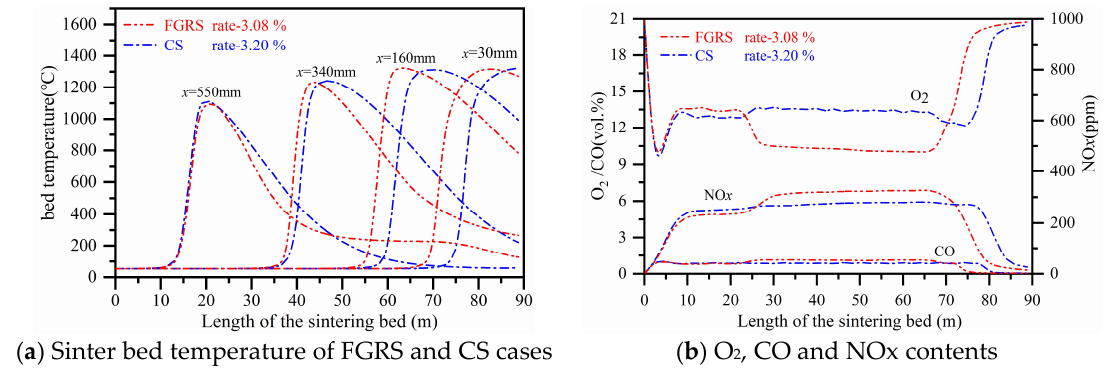
Figure 11. Comparison of sinter bed temperature and flue gas composition of FGRS and CS